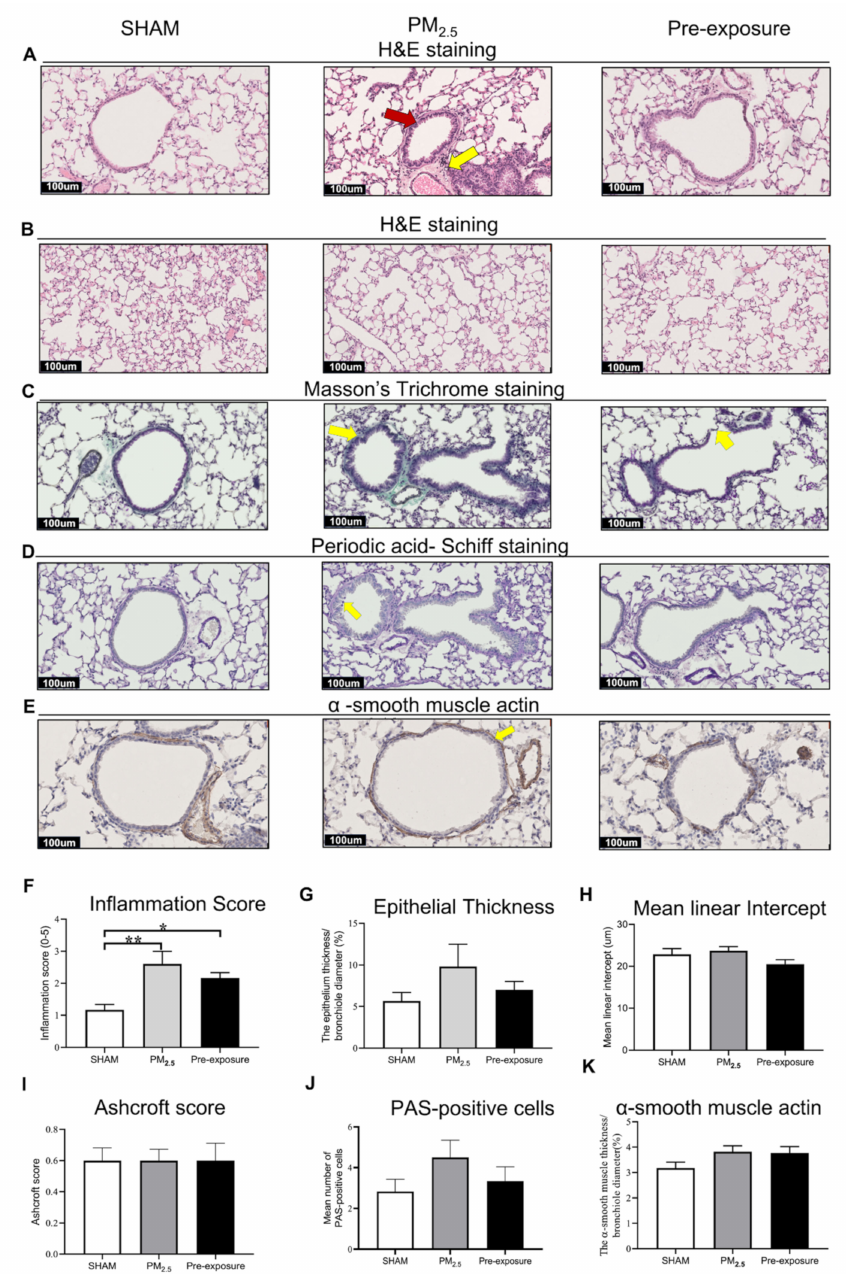
Figure 5. Maternal PM 2.5 exposure increased inflammation in the female offspring at 13 weeks. Rep- resentative images of lung sections stained with ( A ) H&E staining of the airway (yellow arrow point at immune cells and red arrow point at enlarged epithelium in the bronchiole) and ( B ) parenchyma; ( C ) Masson’s trichrome staining (yellow arrows pointed at the collagen); ( D ) Periodic acid-Schiff staining (yellow arrow point at goblet cells); and ( E ) α -smooth muscle actin (yellow arrows point at α -smooth muscle actin). Quantitative results of ( F ) inflammation score, ( G ) epithelial thickness, ( H ) mean linear intercept, ( I ) Ashcroft score, ( J ) PAS-positive cells and ( K ) α -smooth muscle actin. Data were analysed by one-way ANOVA followed by Fisher’s LSD. n = 8. * p < 0.05, ** p < 0.01. PM 2.5 : dams exposed to PM 2.5 (5 µ g/day) prior to mating for 6 weeks during gestation and lactation. Pre-exposure: dams exposed to PM 2.5 for only 6 weeks prior to